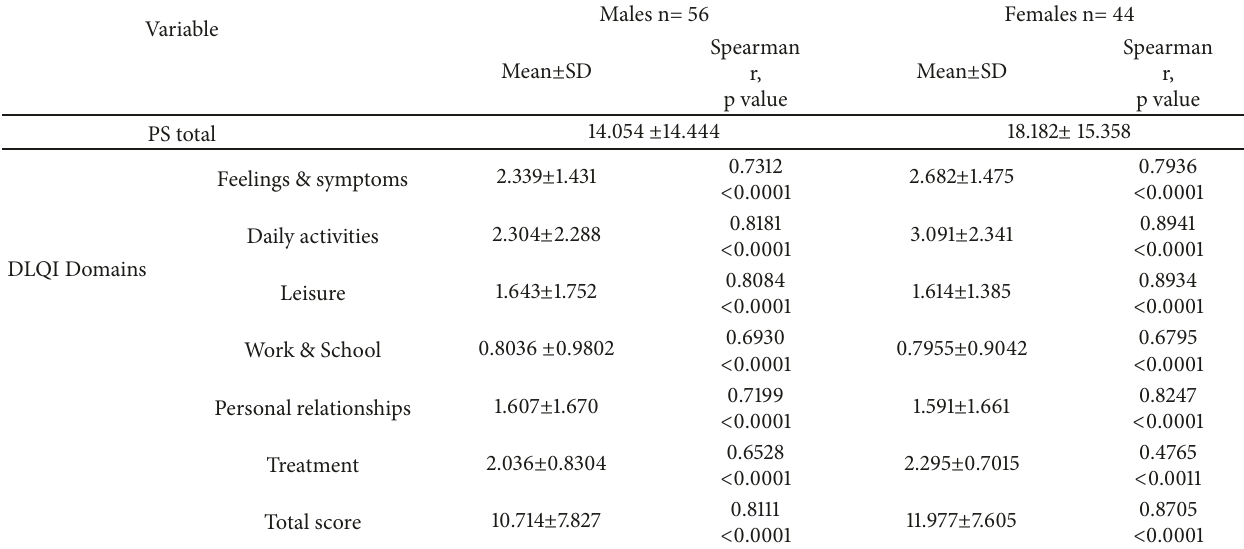
Table 8: Association of stigma with quality of life in both